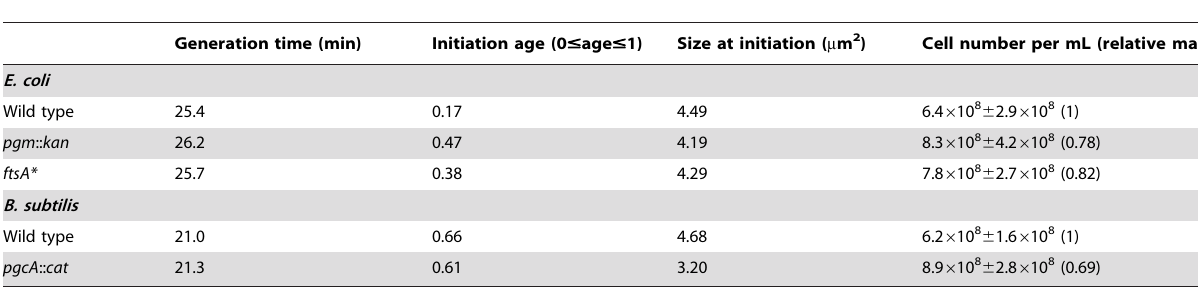
Table 1. Initiation age and mass of E. coli and B. subtilis cells in